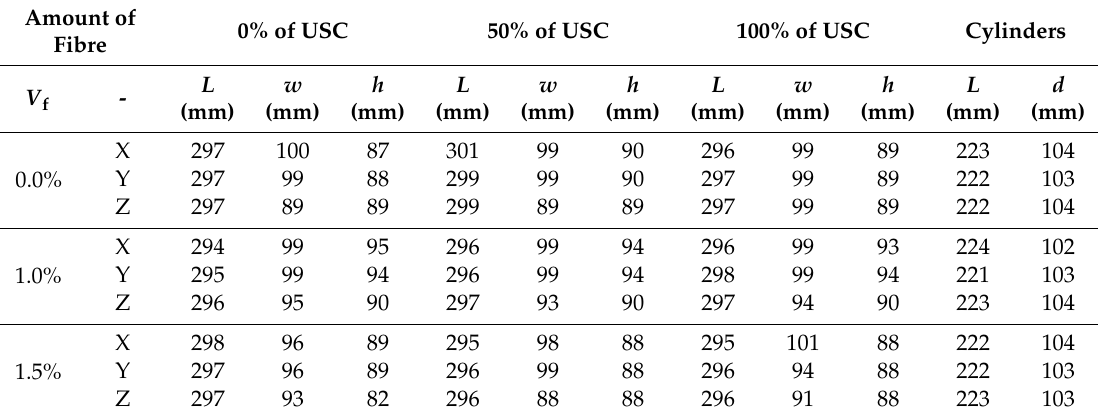
Table 2. Dimensions of the cylindrical and plate